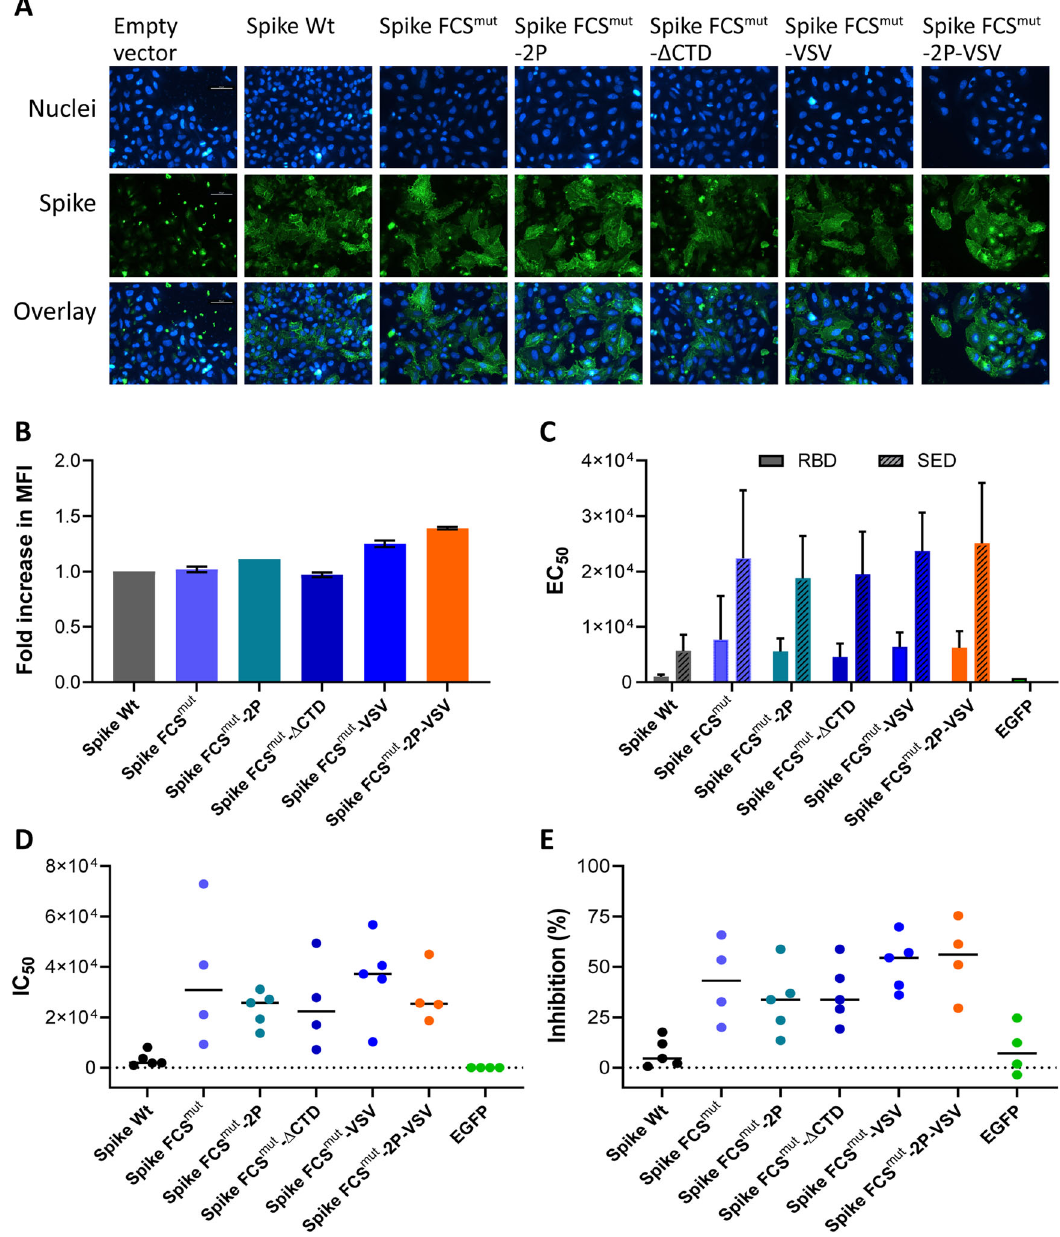
Fig. 2 In vitro expression of SARS-CoV-2 S variants and humoral immune responses in vaccinated guinea pigs. A Antigen expression levels and localization on the surface of HeLa cells using immuno fl uorescence microscopy (scale bar 50 µm). Nuclei were stained with Hoechst (blue colour) and S proteins with an anti-RBD targeting antibody (green colour). B Quanti fi cation of antigen expression levels on the cell surface of plasmid transfected HEK293T cells using FACS by measuring the mean fl uorescence intensity (MFI) at 24 h post-transfection. Immunostaining for the spike protein was the same as in ( A ). C SARS-CoV-2 S antibody levels in sera of VEEV RP vaccinated guinea pigs, collected at day 56 after vaccination/boost, was measured by ELISA using SARS-CoV-2 S RBD (solid colour) or S ectodomain (pattern) as capturing antigens. Shown are the half-maximal effective concentrations (EC 50 ) values of sera collected at the end of the study (expressed as fold dilution). D Neutralizing antibody titers against SARS-CoV-2 S pseudotyped VSV determined on Vero E6 cells, and expressed as the half-maximal inhibitory concentrations (IC 50 , fold serum dilution). E SARS-CoV-2 surrogate virus neutralization test measuring antibody-mediated blockage of S-ACE2 receptor interaction using 10.000-fold diluted serum samples of guinea pigs, collected at the end of the